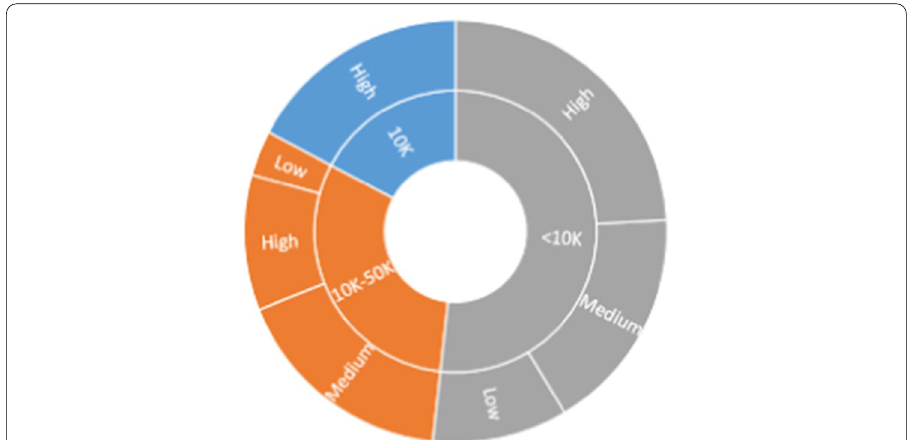
Fig. 13 Average responses per post with respect to the followers’